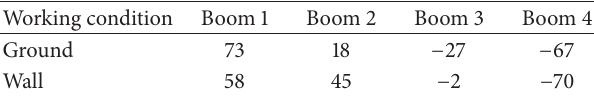
Table 4: Boom test rig parameters value. Table 5: The boom angles of the two working conditions ( ∘